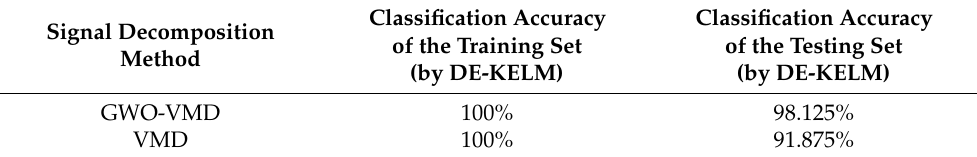
Figure 20. Fault classification results by DE-KELM on the feature matrix calculated through GWO- VMD-based decomposition method. Table 13. Fault classification accuracy of the training and testing sets by